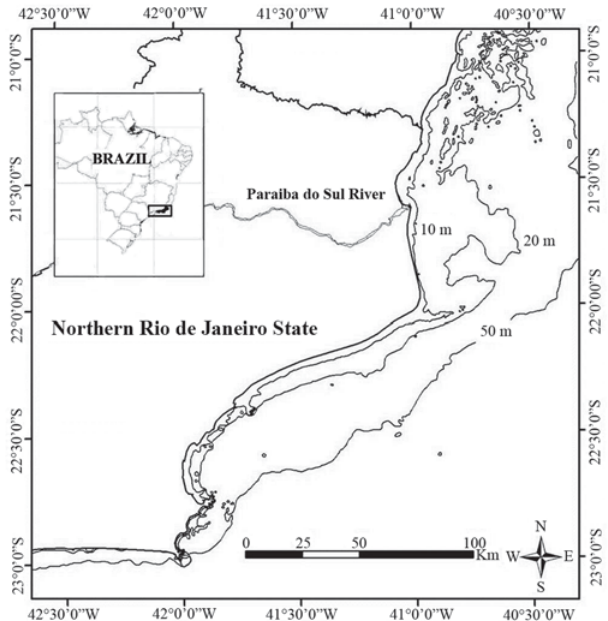
Fig. 1. Map of Brazil with Rio de Janeiro State and its northern coast, where adult female specimens of Trichiurus lepturus and their prey species were collected (21º18’S-22º25’S; until 50 m